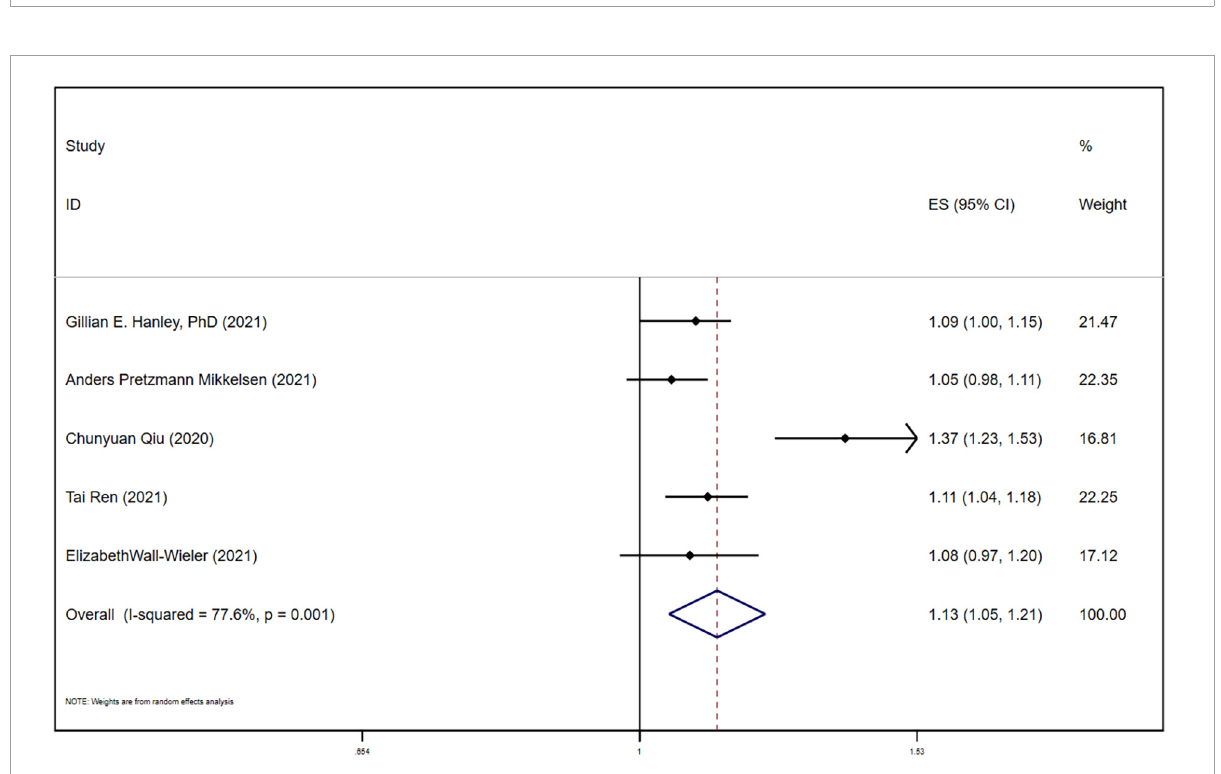
FIGURE5 Forest plot for multivariate HR of LEA and